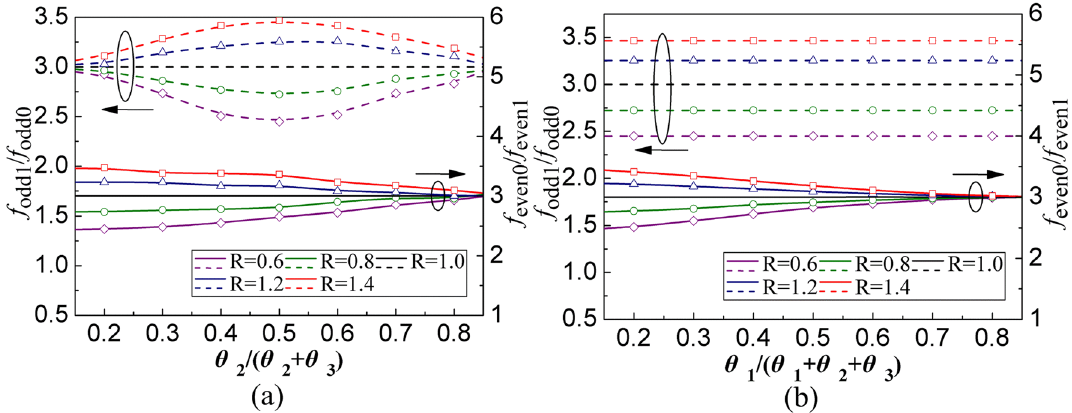
Figure 5. The first odd-mode fodd1 normalized by fodd0 and the first even-mode feven1 normalized by feven0 against various of ( a ) θ 2 /(θ 2 + θ 3 ) and ( b ) θ 1 /(θ 1 + θ 2 + θ 3 ) .